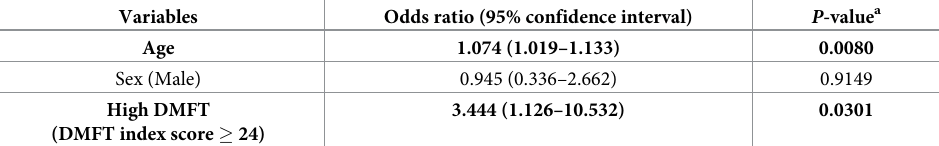
Additive multivariate logistic regression models adjusted for age and sex were used for these analyses in patients on HD. The association between pulse pressure > 80 mmHg and high DMFT index scores ( � 24) remained significantly different in a subsequent logistic regression analysis adjusted for age and sex. Independent variables were age, sex, and high DMFT index score ( � 24). The dependent variable was pulse pressure > 80 mmHg. DMFT scores: the numbers of total, decayed (DT), missing (MT), and filled (FT) teeth. a Bold values indicate statistical significance at p <